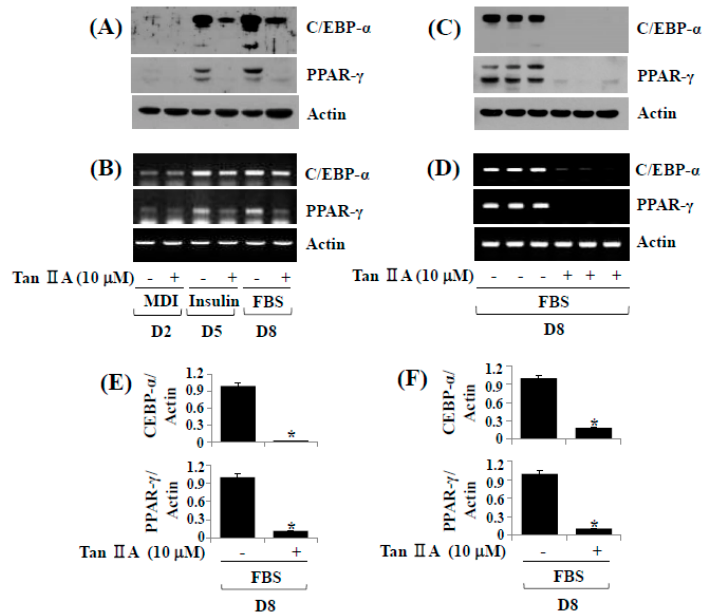
Figure 2. Effects of tanshinone IIA on protein and mRNA expression levels of CCAAT/enhancer- binding protein- α (C/EBP- α ) and peroxisome proliferator-activated receptor- γ (PPAR- γ ) during 3T3-L1 preadipocyte differentiation. ( A , B ) 3T3-L1 preadipocytes were differentiated with induction medium containing a cocktail of hormones (MDI) that include 0.5 mM IBMX (M) 0.5 µ M dexamethasone ( D ) and 5 µ g/mL insulin (I) insulin, and fetal bovine serum (FBS) in the presence or absence of tanshinone IIA, and harvested at days 2, 5 and 8, respectively. Total cellular protein and RNA at the indicated time point were extracted and analyzed by Western blot ( A ) and reverse transcription-polymerase chain reaction (RT-PCR ( B ) analysis, respectively; ( C , D ) Western blot ( C ) and RT-PCR ( D ) analysis in triplicate experiments on D8, respectively; ( E , F ) The densitometry data of ( C , D ), respectively. * p < 0.05 compared to the value of tanshinone IIA free control at the indicated day.